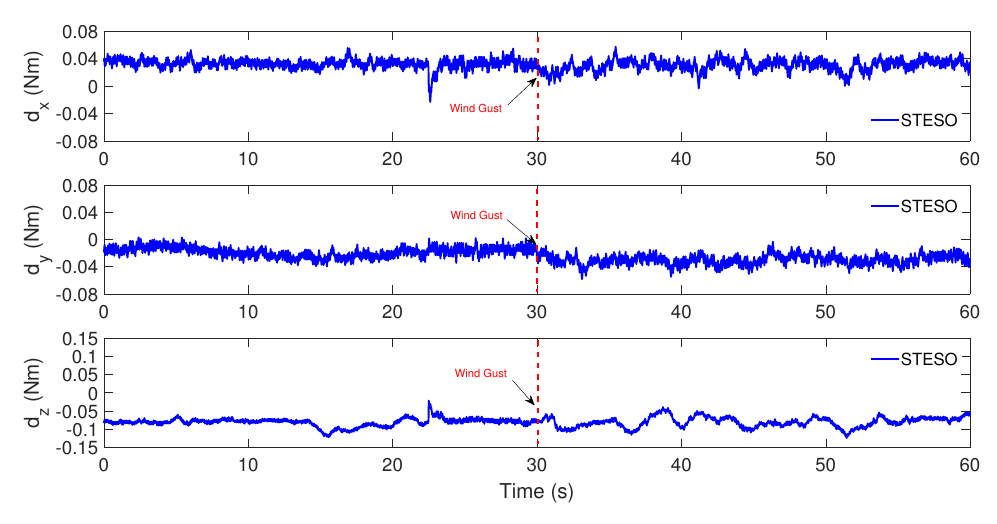
Figure 14. Disturbance estimation results of STESO in Case B.